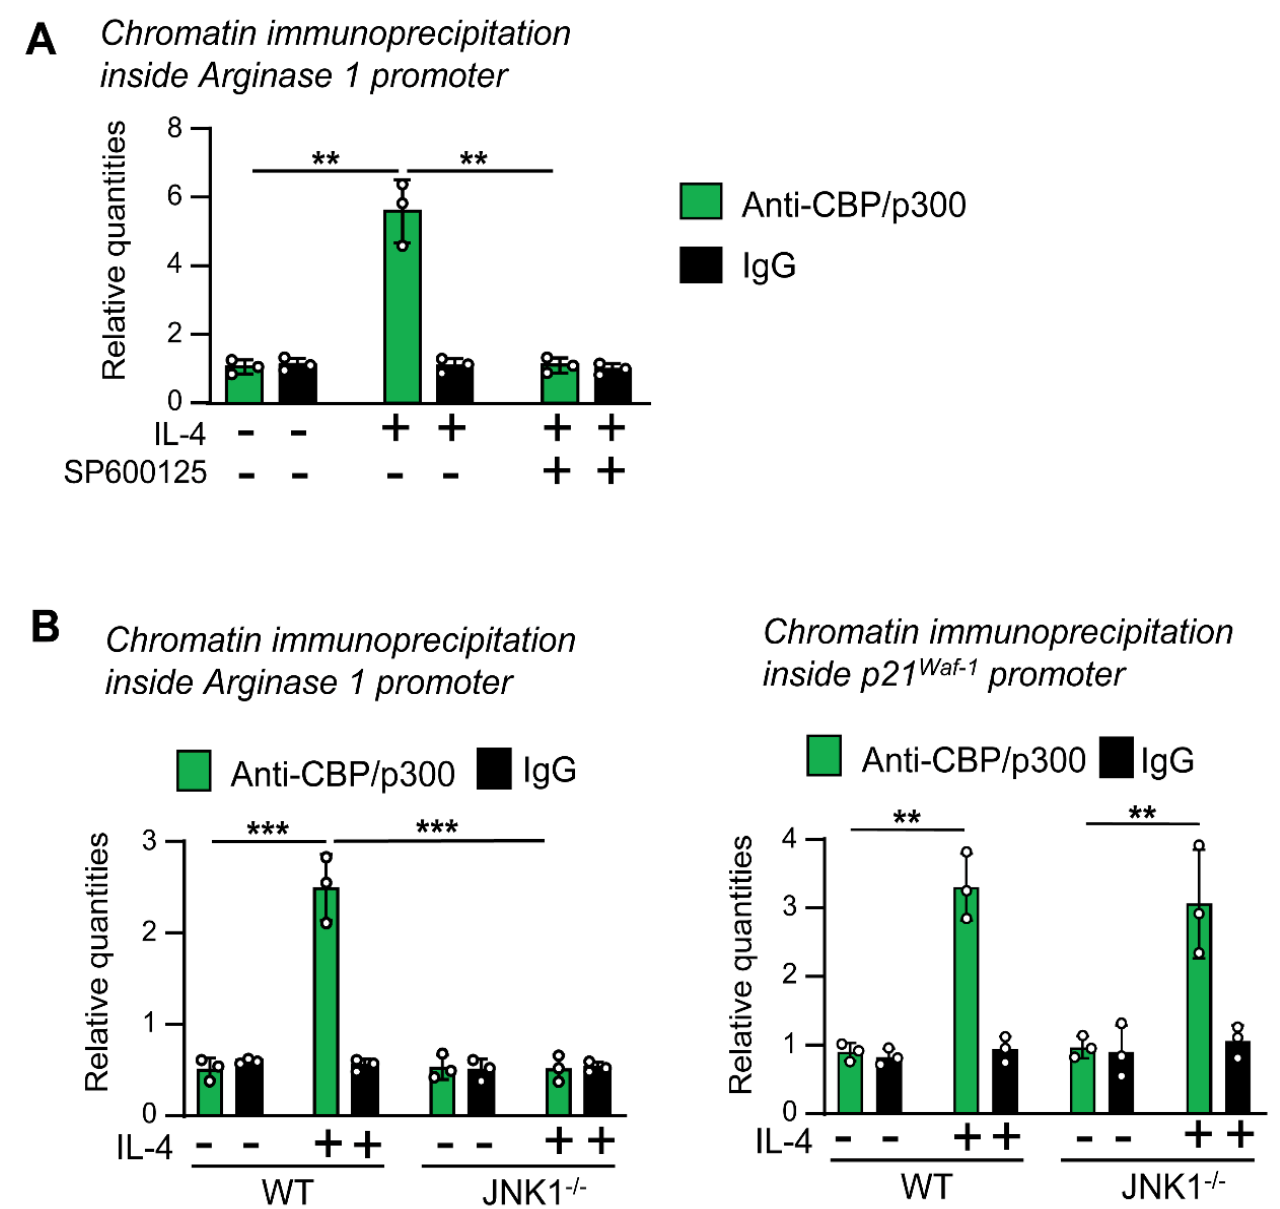
Figure 7. JNK-1 activity is required for the binding of the cofactor CBP/p300 to the Arginase 1 promoter in response to IL-4 but not to the p21 Waf − 1 promoter. Quiescent macrophages were treated with IL-4 for 15 min. In A, the cells were pretreated for 1 h with the JNK inhibitor SP600125 (SP) or the vehicle (DMSO) before the addition of IL-4. ( A , B ) Chromatin immunoprecipitation assay was performed with the antibodies indicated. The expression of the promoters was evaluated by quantitative PCR and normalized with the level of expression of a 36B4 exon and the inputs of each sample as a control for loading. The results are shown as the mean ± SD of 3 independent experiments. ** p < 0.01, and *** p < 0.001 in relation to the corresponding treatments after all the independent experiments had been compared. Data were analyzed using Student’s t -test.